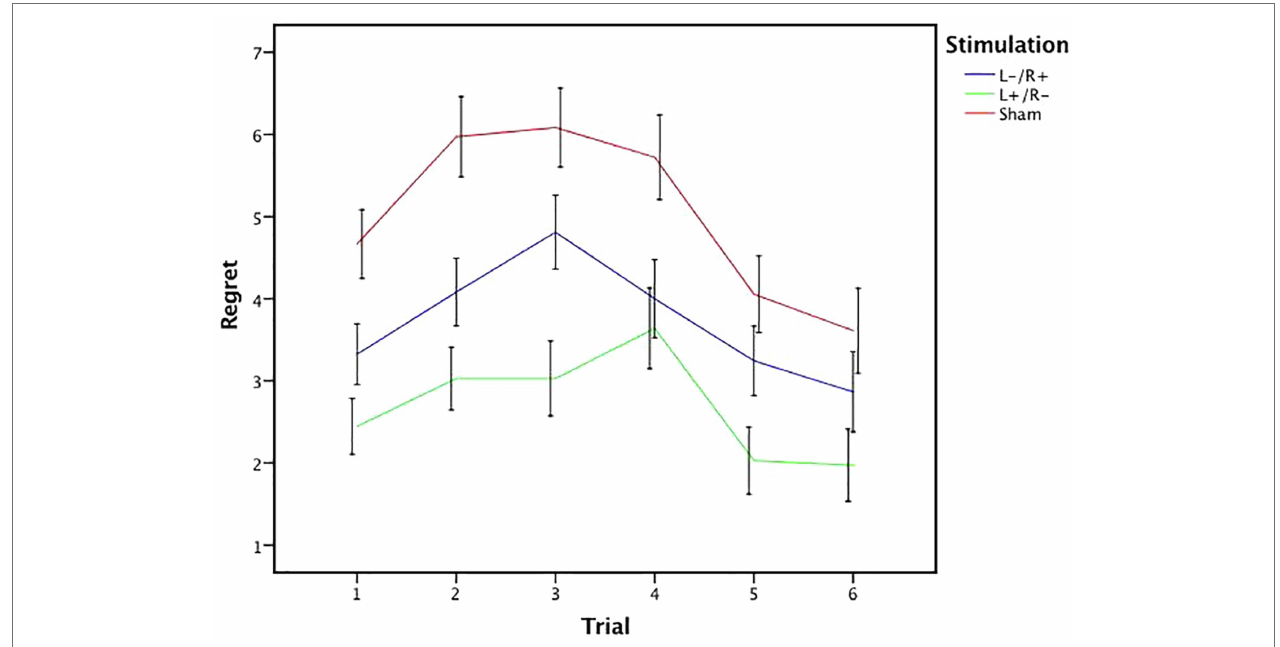
FIGURE 5 | Mean value of regret ratings under different stimulation conditions. The mean regret ratings across three stimulations from trial 1 to trial 6. Error bars represent